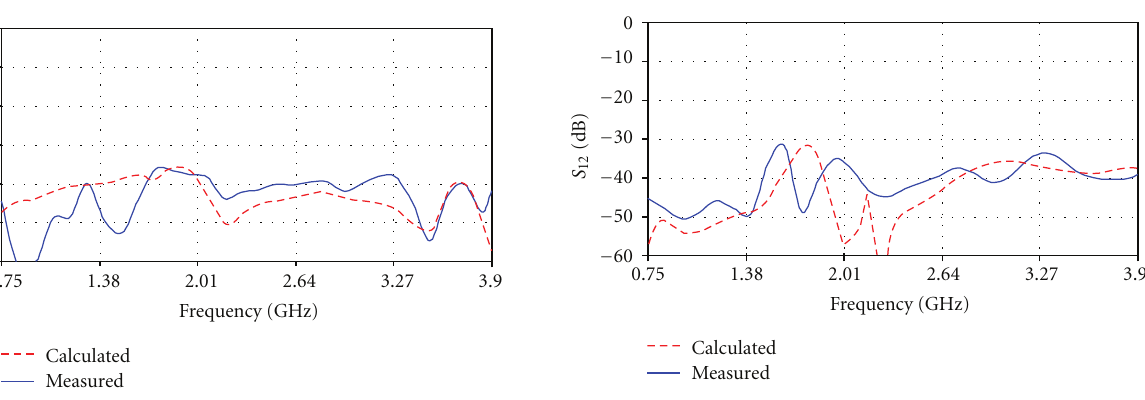
Figure 13: Mutual coupling ( S 12 ) between the antennas of the third configuration on a handset.